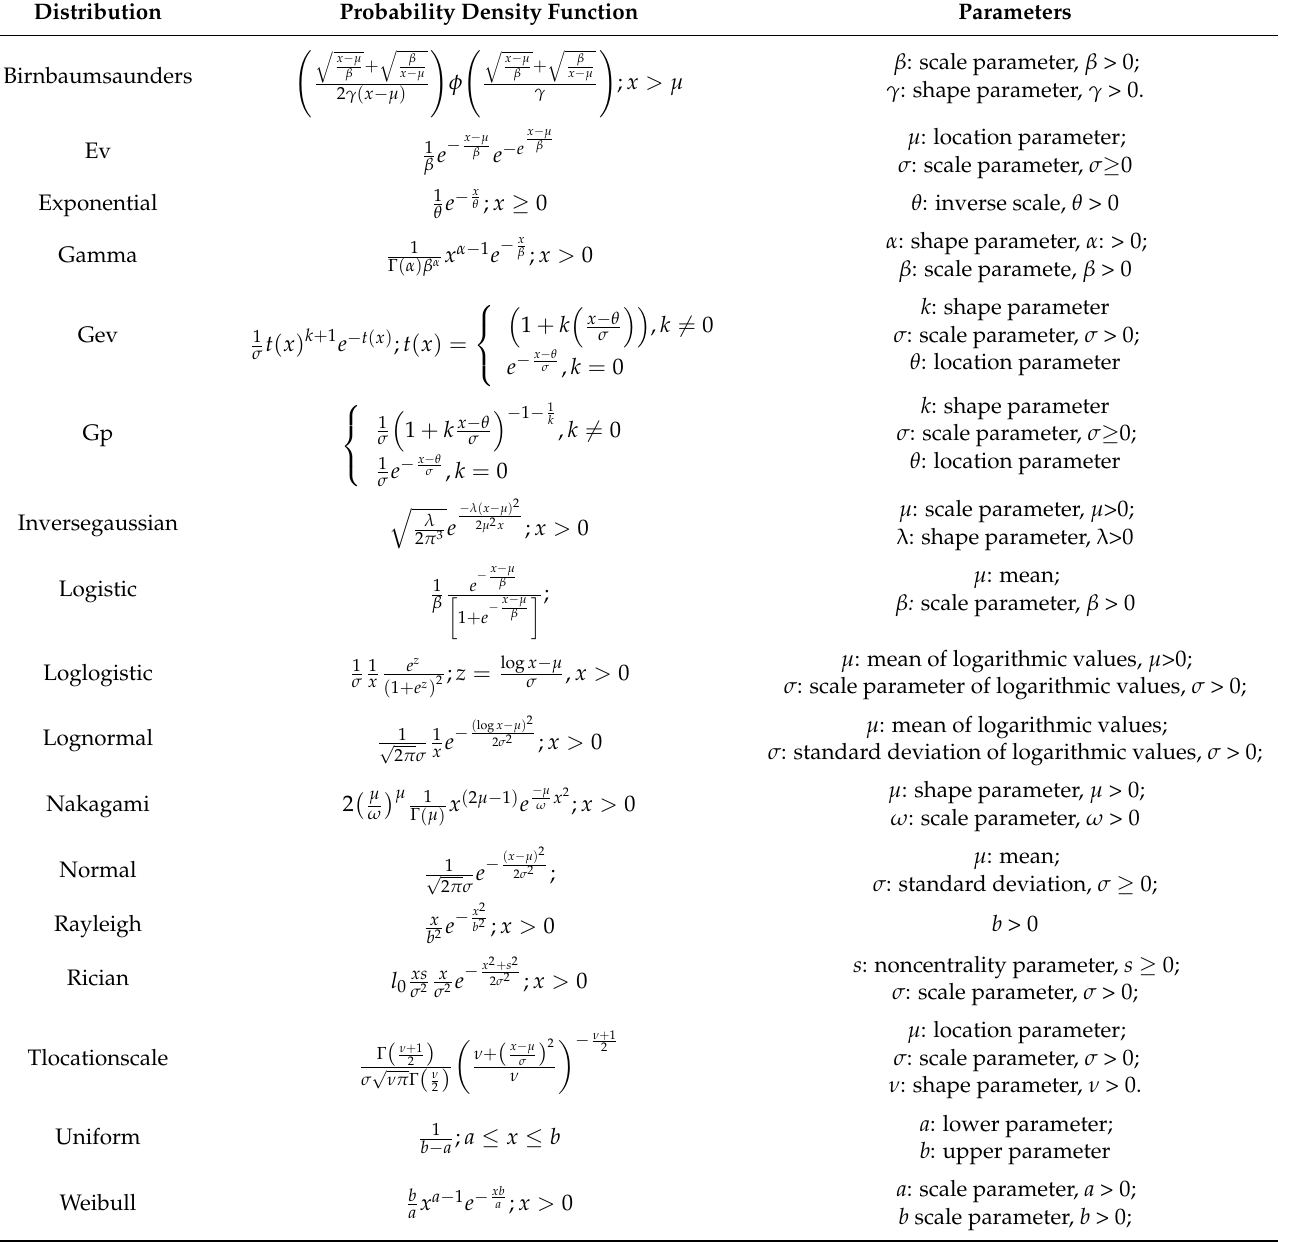
Table 1. Probability density functions of different distributions used to fit the speed data. Distribution Probability Density